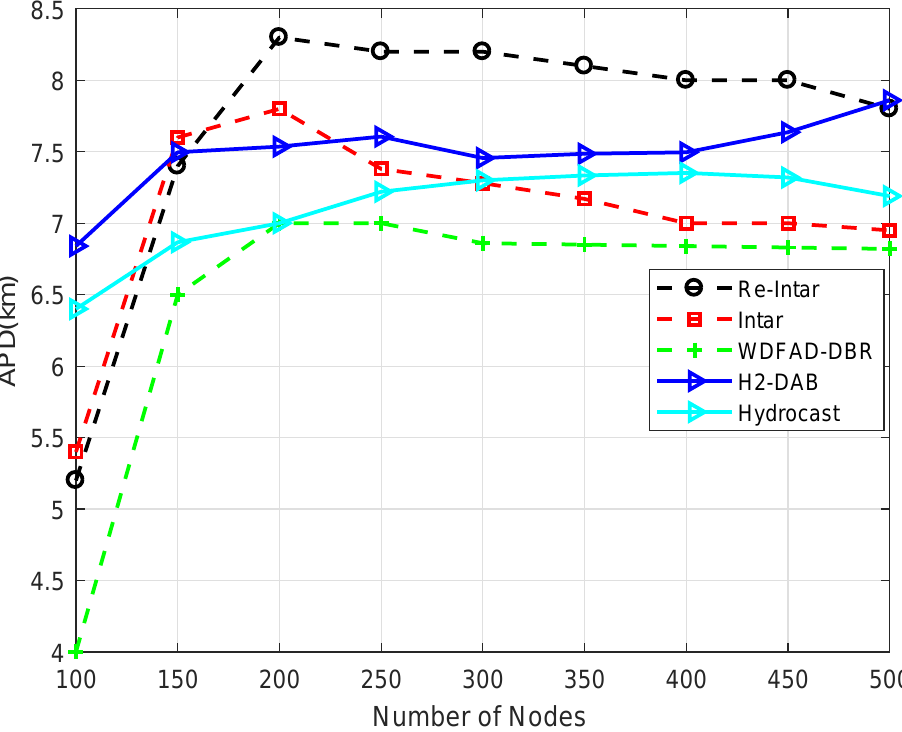
Figure 7. APD of the existing and proposed protocols with varying number of